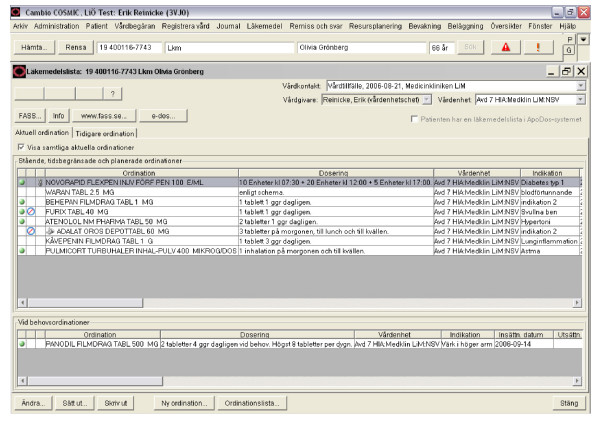
The physicians' interface to the CPOE system. A figure showing the physicians' view of the CPOE system.